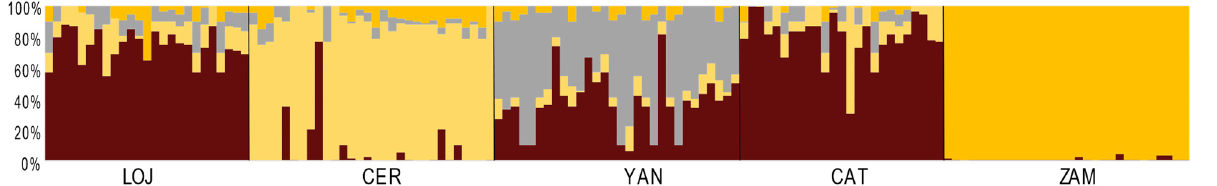
Figure 3. Genetic structure of Ocotea rotundata samples based on the best assignment results retrieved by STRUCTURE (K = 4). Each sample is represented by a thin vertical line divided into K-colored segments that represent the individual’s estimated membership fractions in K clusters. Population labels refer to Table 2.